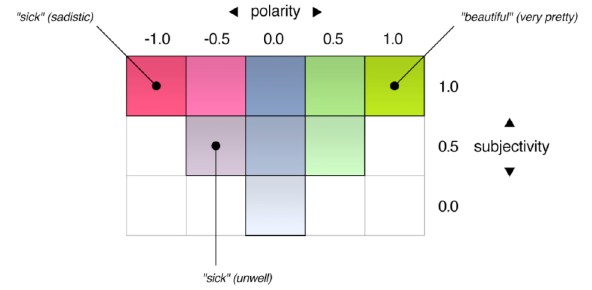
Figure 7. Representation of polarity and subjectivity scores by